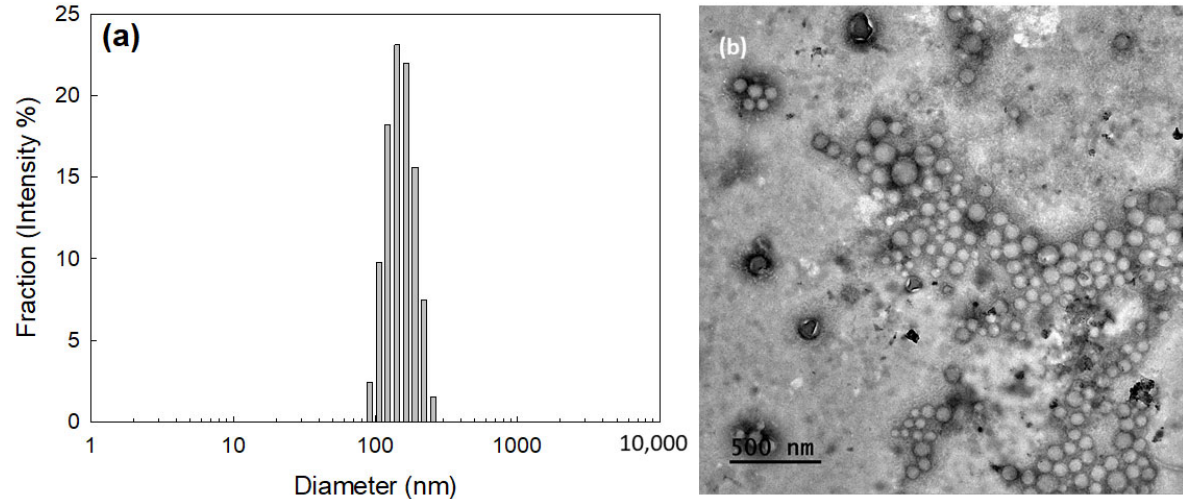
Figure 2. HAthCe6 nanophotosensitizers. ( a ) Particle size distribution and ( b ) TEM image. Average particle size was 146.1 ± 35.3 nm, as described in Table 1. Poly ‐ dispersity index (PDI) was 0.036. For TEM images, nanophotosensitizers were negatively stained with phosphotungstic acid.